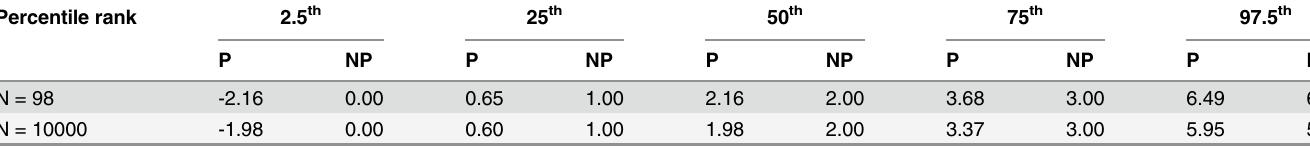
Table 4. Parametric and nonparametric percentile rank values in simulated non-Gaussian data. Percentile rank 2.5